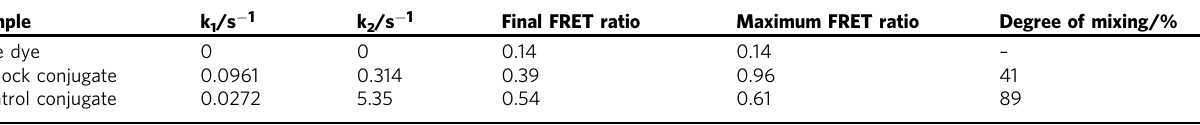
Table 1 Rate constants for FRET exchange, fi nal and maximum FRET ratio and degree of mixing for the free dye, diblock (5 and 6) and control (7 and 8) dye